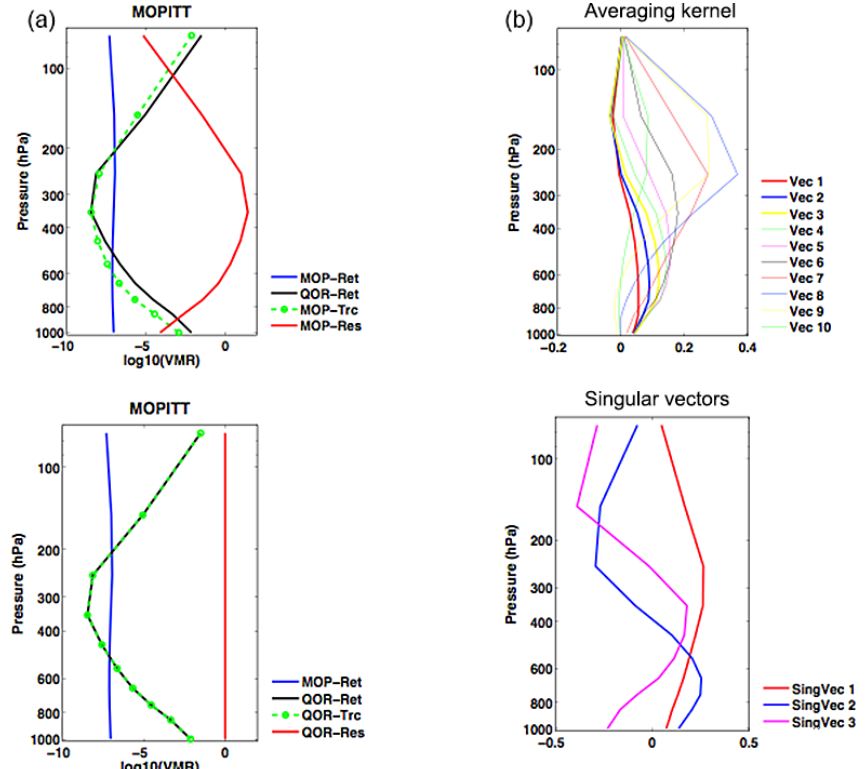
Figure 4. (a) Horizontal domain average of the full and truncated terms in the retrieval equation for 18:00UTC, 28 June 2008. MOP-Ret, MOP-Trc, and MOP-Res are the MOPITT retrieval, truncated retrieval, and residual profiles, respectively. QOR-Ret is the MOPITT QOR profile, QOR-Trc is the truncated MOPITT QOR profile, and QOR-Res is the MOPITT QOR residual profile. (b) Horizontal domain average of the MOPITT averaging kernel profiles in the upper panel and leading left singular vectors of those averaging kernels in the lower panel for 18:00UTC, 28 June